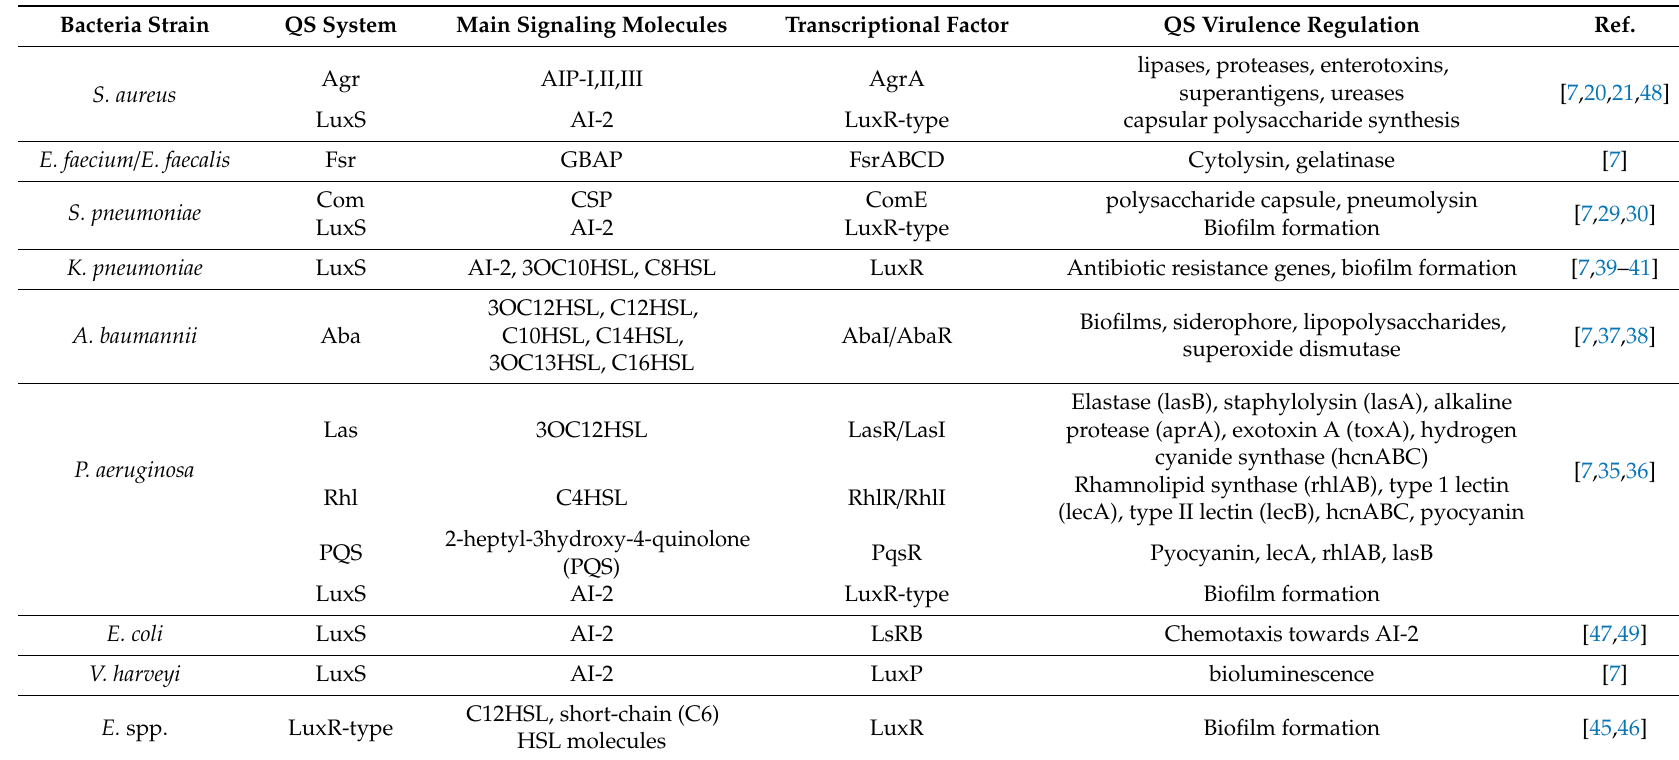
Table 1. QS networks and key players in ESKAPE